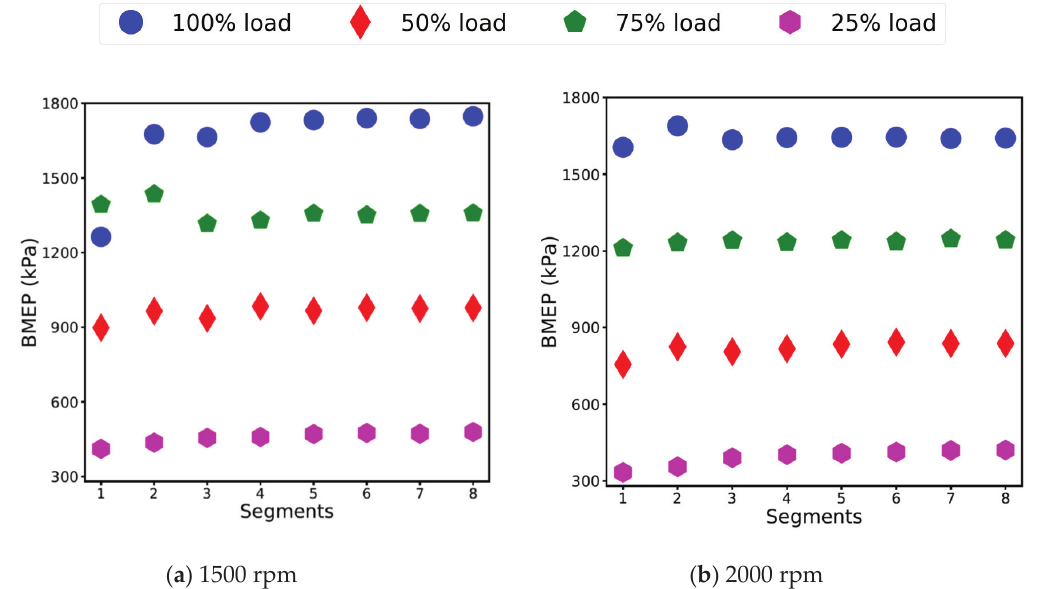
Figure 7. Brake mean e ff ective pressure (BMEP) at each load in each segment at ( a ) 1500 and ( b ) 2000 rpm. The blue circle represents 100% load, the red diamond 50% load, the green pentagon 75% load and the pink hexagon 25%